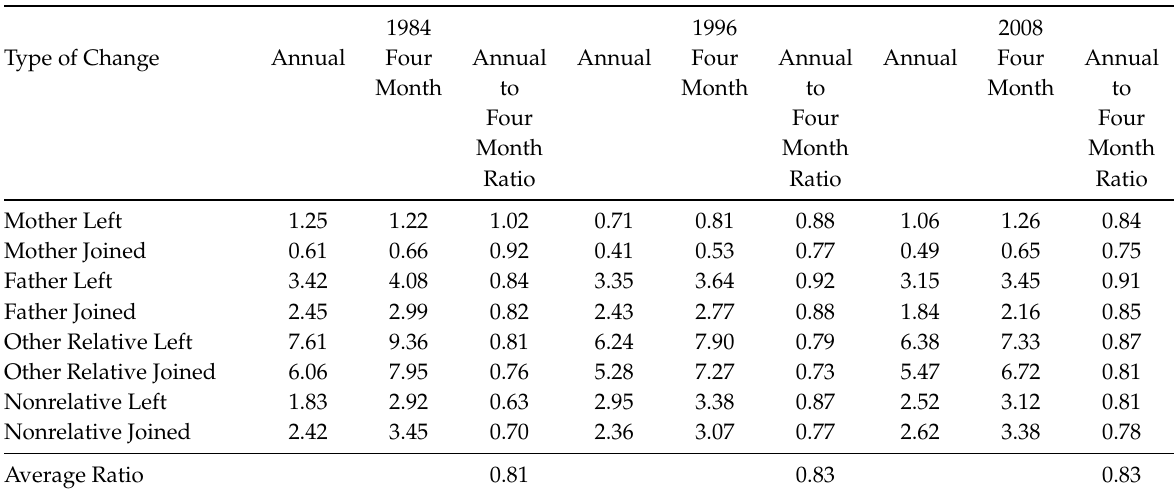
Table 2: Weighted cumulative percent of children (by SIPP panel) experiencing change after two years: annual and four-month measure and ratio of annual to four-month